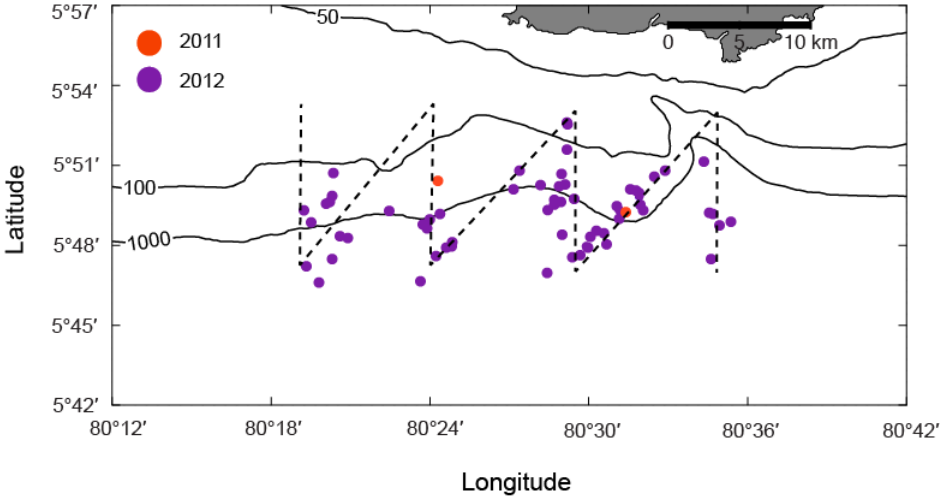
Figure 4. Blue whale distribution based on data collected during systematic transects. Orange dots indicate sightings from 2011 and purple dots indicate sightings from 2012. Dashed line indicates the vessel trackline for both years.